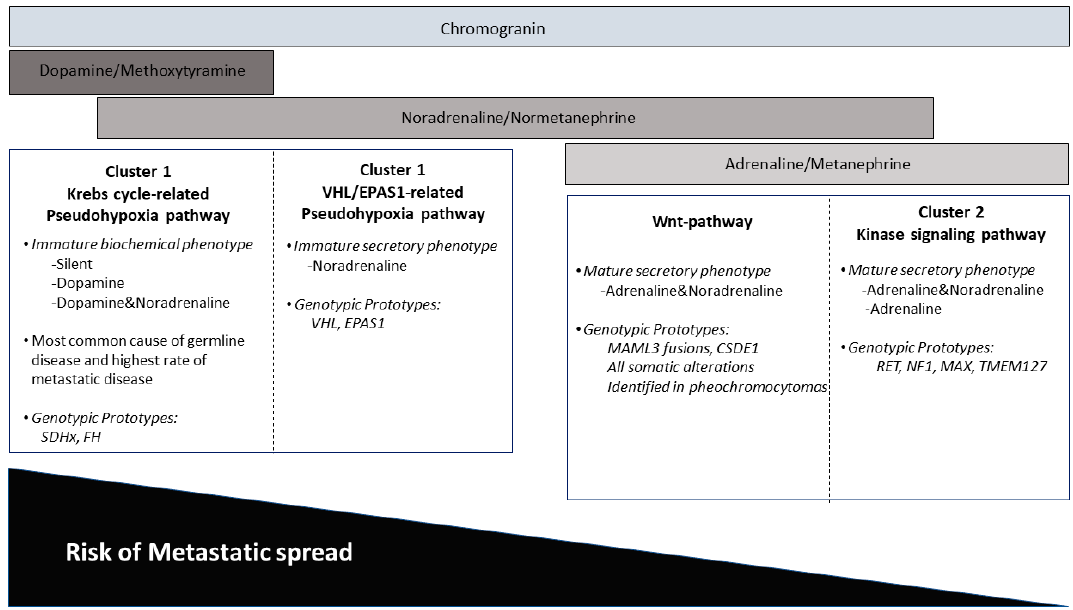
Figure 5. Biochemical and genetic clusters of paragangliomas.